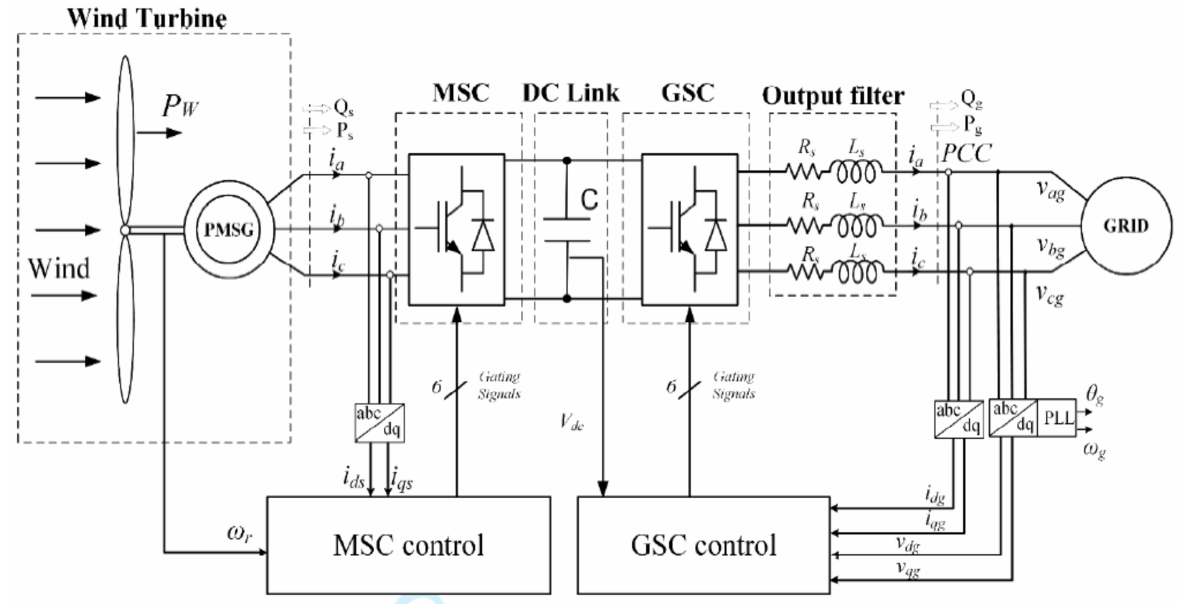
Figure 4. PMSG wind turbine with back-to-back power